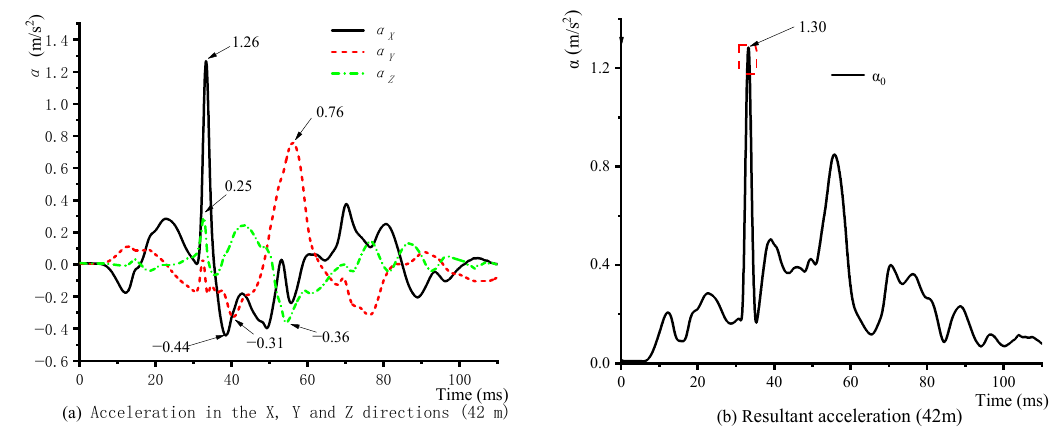
Figure 6. Acceleration data measured at 42 m in the one-ton TNT ground explosion test. It may be observed from Figures 5a and 6a that the maximum positive and negative acceleration in the X direction decreased by 88 and 91.9%, respectively, in correspondence with the increase in distance from the blast site from 21 to 42 m. The corresponding decreases were 94 and 96.8% in the Y direction and 84.1 and 90% in the Z direction, respectively. Thus, it is evident that consequent to an explosion, the accelerations induced by the ground shock in the X, Y, and Z directions decreased very significantly with the increase in distance from the blast site. At 21 m, the maximum positive accelerations in the X and Y directions were 6.65 and 8.15 times that in the Z direction. Likewise, the maximum negative accelerations in the X and Y directions were 1.52 and 2.67 times that in the Z direction. At 42 m, the maximum positive accelerations in the X and Y directions were 5.04 and 3.04 times that in the Z direction, while the maximum negative accelerations in the X and Y directions were 1.22 and 0.86 times that in the Z direction. It is apparent that the intensity of the explosion-induced ground shock decreased with the increasing distance from the blast site, and that the accelerations in the X and Y direction were both higher than that in the Z direction. The numerical dominance of the ground-shock-induced accelerations in the X and Y values implies that the structural effects of ground shocks are concentrated in the X and Y direction, while the effects in the Z direction are considerably weaker. Figure 7 is the velocity–time curve of the 21 m point. It may be observed that the real particle vibration velocity exceeded the range of the velocity sensor, which caused clipping in the measured velocity–time curve.